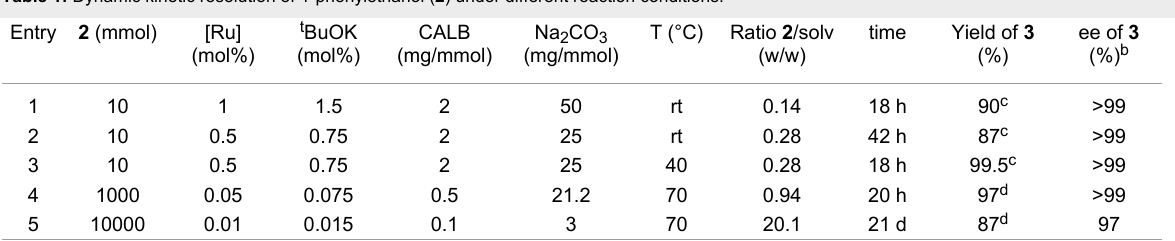
Table 1: Dynamic kinetic resolution of 1-phenylethanol ( 2 ) under different reaction conditions. a Entry 2 (mmol)